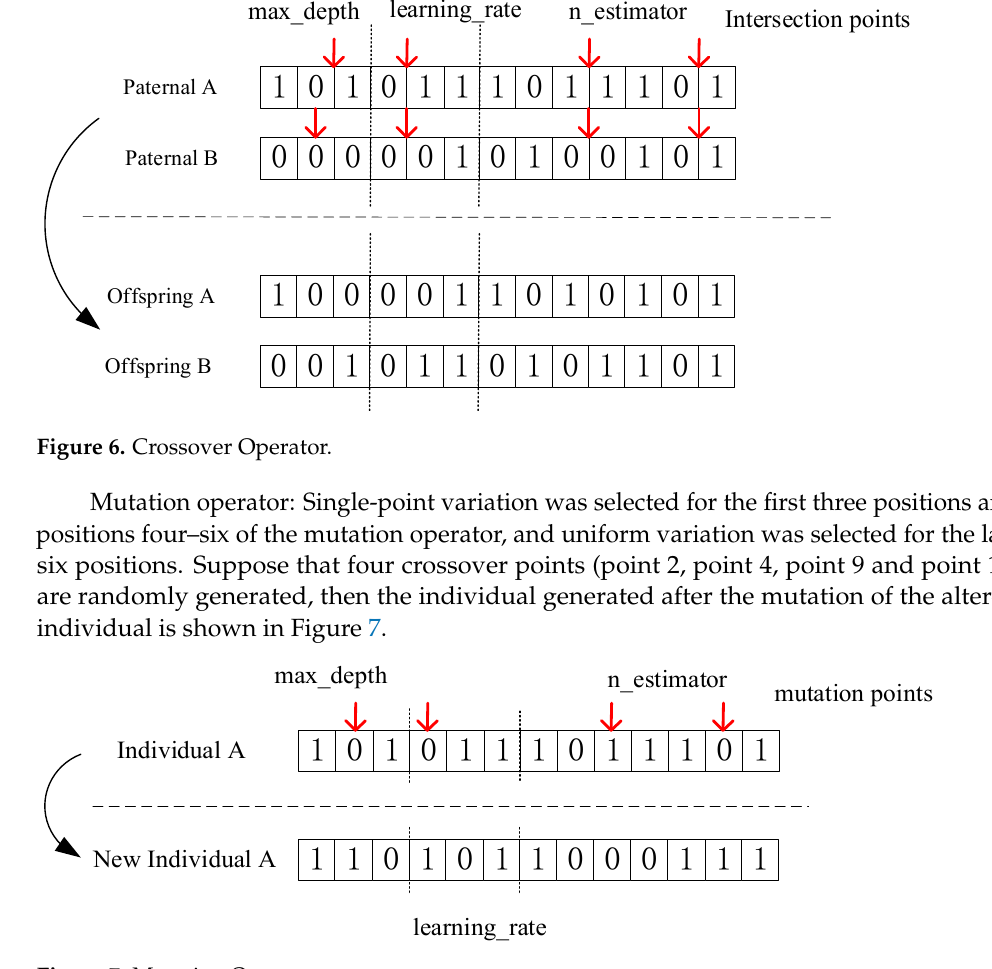
Figure 7. Mutation Operator.